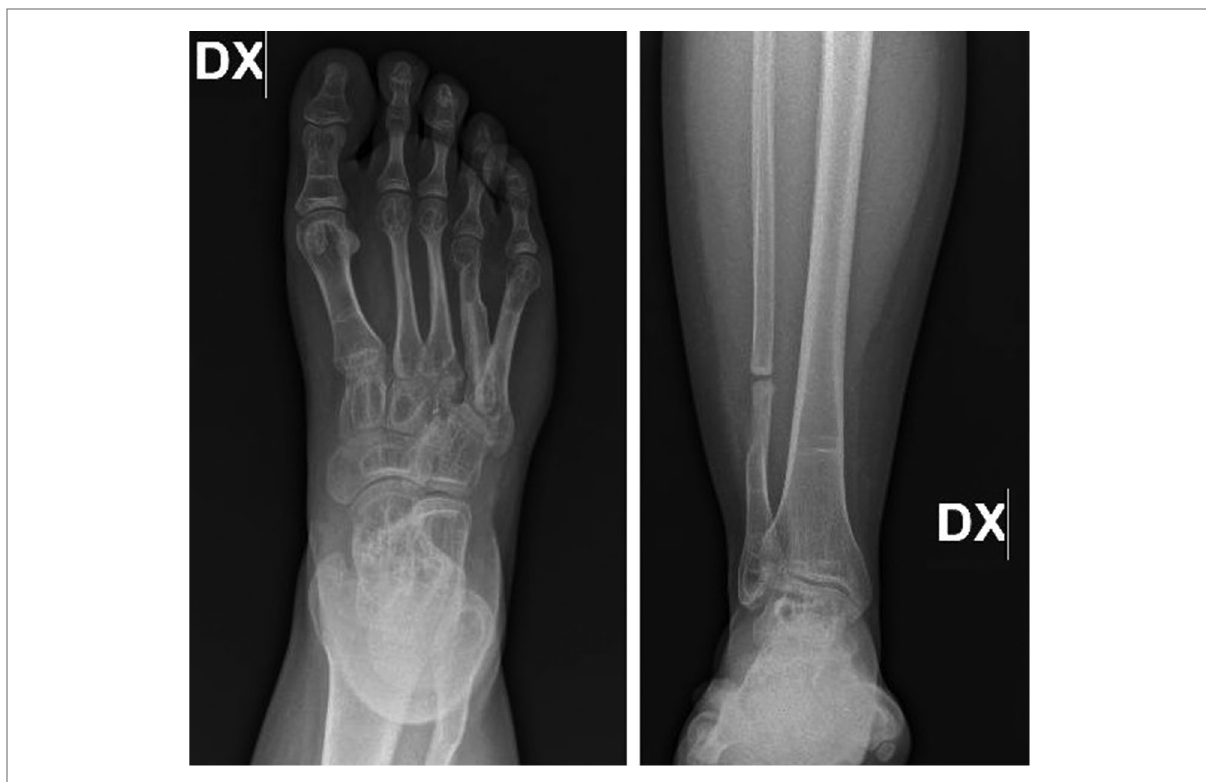
FIGURE 4 Follow-up x-ray of the foot and leg respectively taken at 12 months ( A ) and 24 months ( B ) showing incorporation of graft with no evidence of recurrences or other lesions and the donor site with an almost full recovery of the bone fi bular